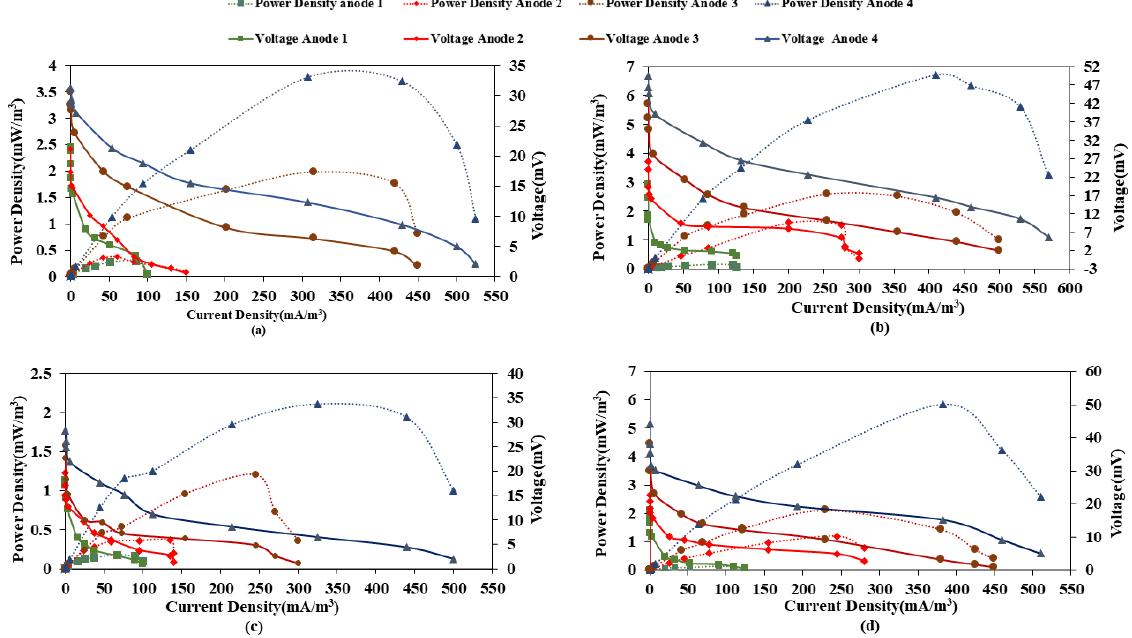
Figure 5. Polarization curves for ( a ) CW-MFC (GG), ( b ) CW-MFC(GAC) at an organic loading rate of 890.11 g COD/m 3 -d, ( c ) CW-MFC (GG), and ( d ) CW-MFC (GAC) at an organic loading rate of 1781.32 g COD/m 3 -d.